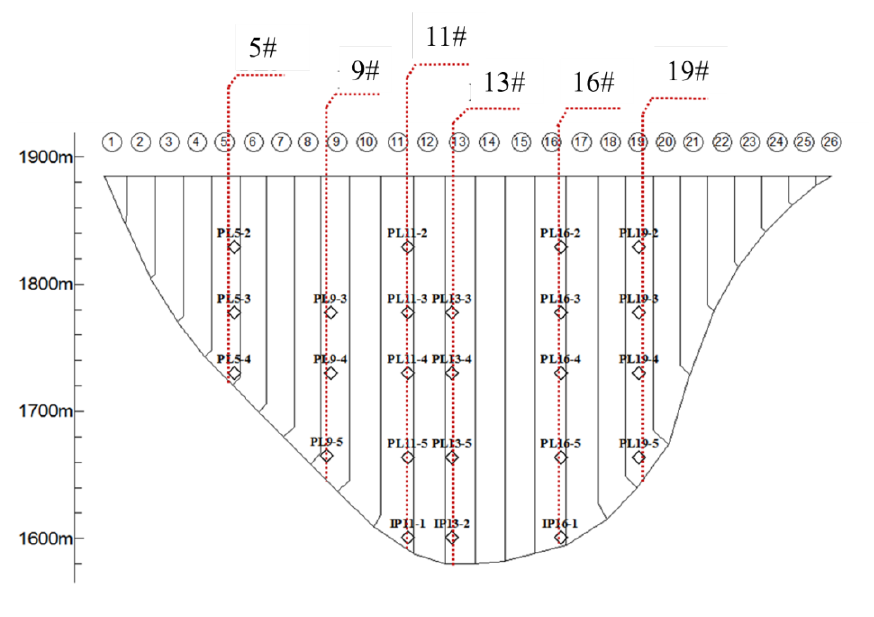
Figure 5. Distribution map of the measuring points.